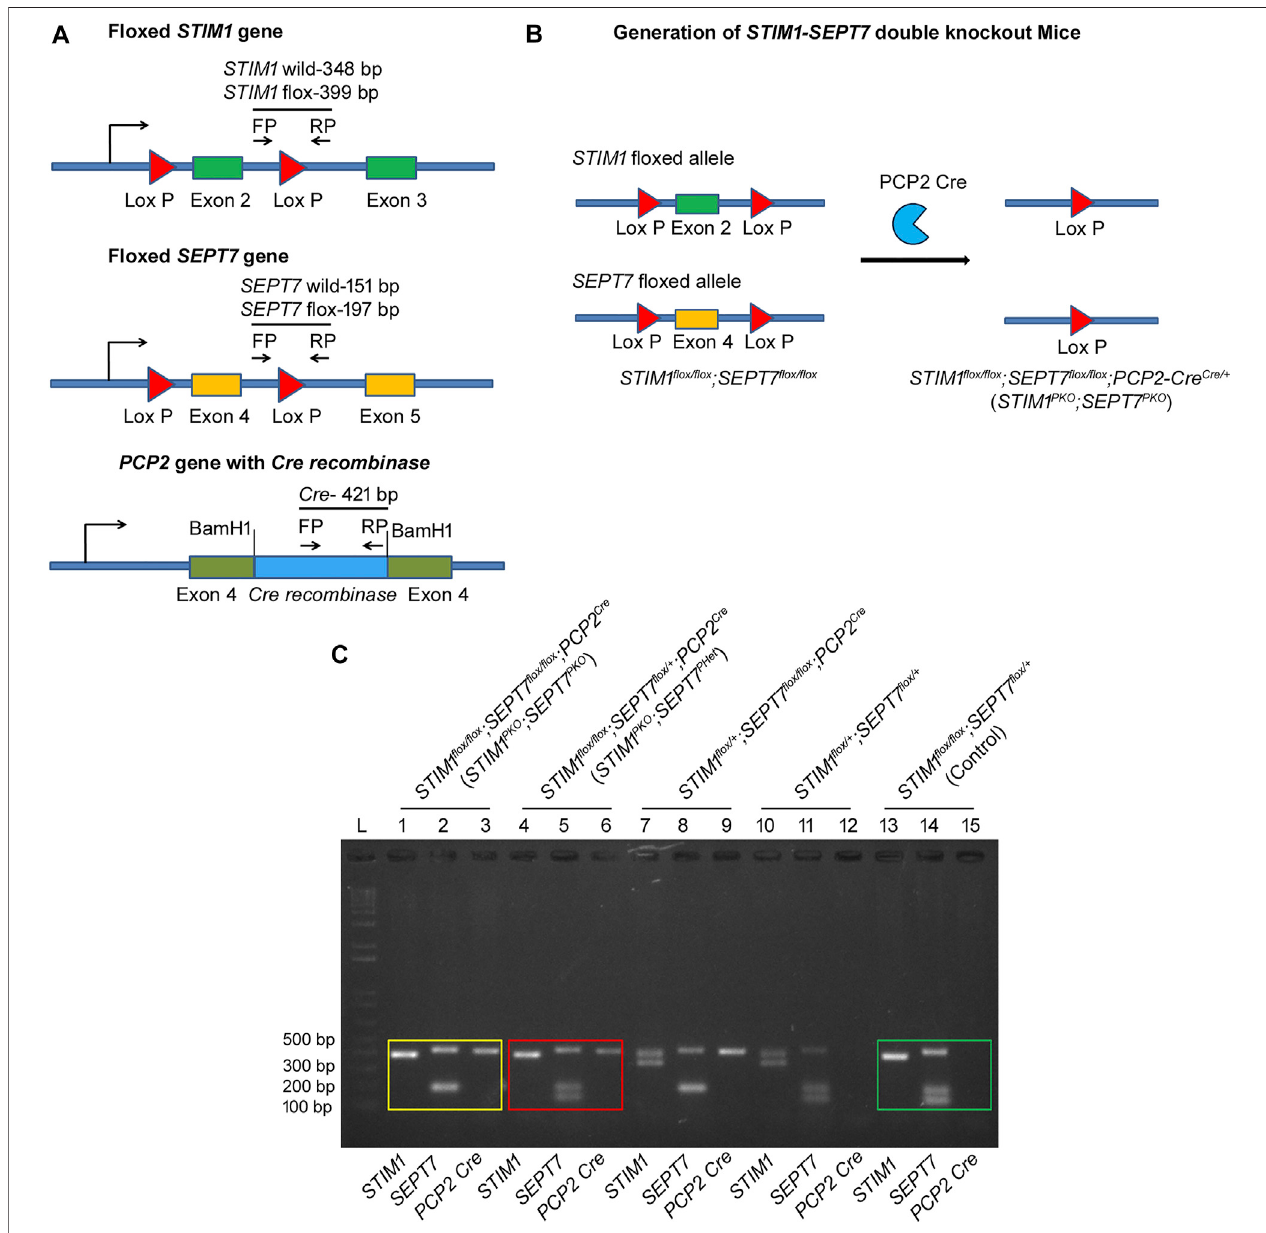
FIGURE1| Generationof STIM1 – SEPT7 doubleknockoutmice. (A)(Top) Schematicdiagramwithexon2of STIM1 gene fl ankedby loxP recombinationsites(red triangles). Cre-mediated recombination will result in the deletion of exon 2. (Middle) Schematic diagram with exon 4 of SEPT7 gene fl anked by loxP recombination sites (red triangles). (Bottom) Schematic diagram showing insertion of Cre-recombinase cDNA into the exon 4 of PCP2 gene. Primers used for genotyping are indicated by arrows (FP, forward primer and RP, reverse primer). (B) Triple transgenic mouse strain STIM1 fl ox/ fl ox ; SEPT7 fl ox/ fl ox ; PCP 2Cre/+ ( STIM1 PKO ; SEPT7 PKO ) was generated by cross-breeding homozygous double transgenic STIM1 fl ox/ fl ox ; SEPT7 fl ox/ fl ox mice with STIM1 fl ox/+ ; PCP2-Cre cre/+ mice to generate STIM1 and SEPT7 double knockout mice. (C) Agarose gel showing the genotyping of STIM1 – SEPT7 double knockout mice. PCRs of genomic DNA from STIM1 fl ox/ fl ox ; SEPT7 fl ox/ fl ox ; PCP 2Cre/+ ( STIM1 PKO ; SEPT7 PKO )miceareshownonLanes1 – 3.PCRswereperformedseparatelyforeachgene,andPCRproductswereloadedseparatelyindifferent lanes.Asinglebandat399bpindicateshomozygous STIM1 fl ox (Lane1),abandat197bpindicateshomozygous SEPT7 fl ox (Lane2),andthe421-bpbandisfromthe PCP2-Cre allele (Lane 3). PCRs with genomic DNA from STIM1 fl ox/ fl ox ; SEPT7 fl ox/+ ; PCP 2Cre/+ ( STIM1 PKO ; SEPT7 PHet ) mice are shown in Lanes 4 – 6. Lanes 13 – 15 indicate genotyping of control mice STIM1 fl ox/ fl ox ; SEPT7 fl ox/+ . DNA band sizes are as described before. “ L ” denotes DNA ladder.